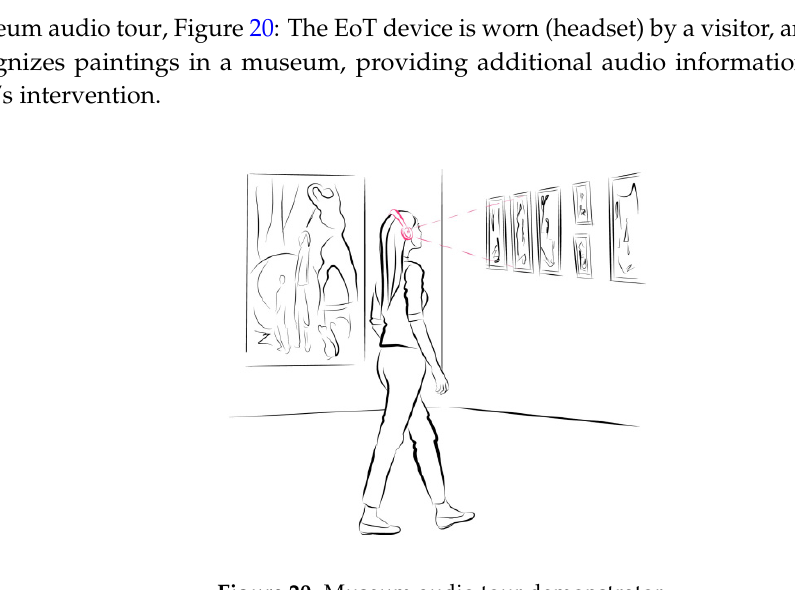
Figure 20. Museum audio tour